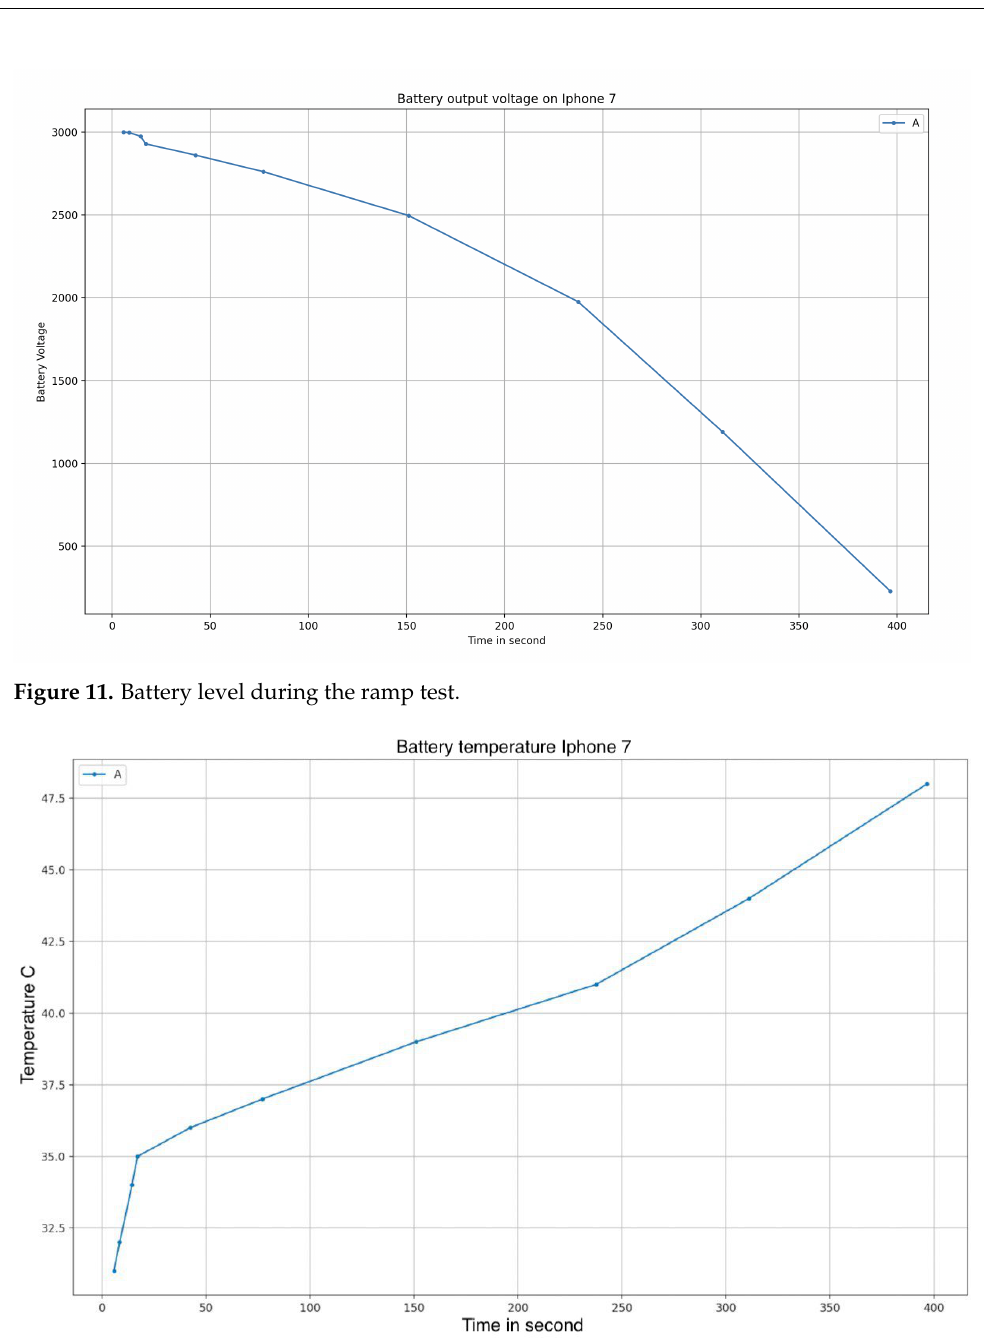
Figure 12. Battery temperature during